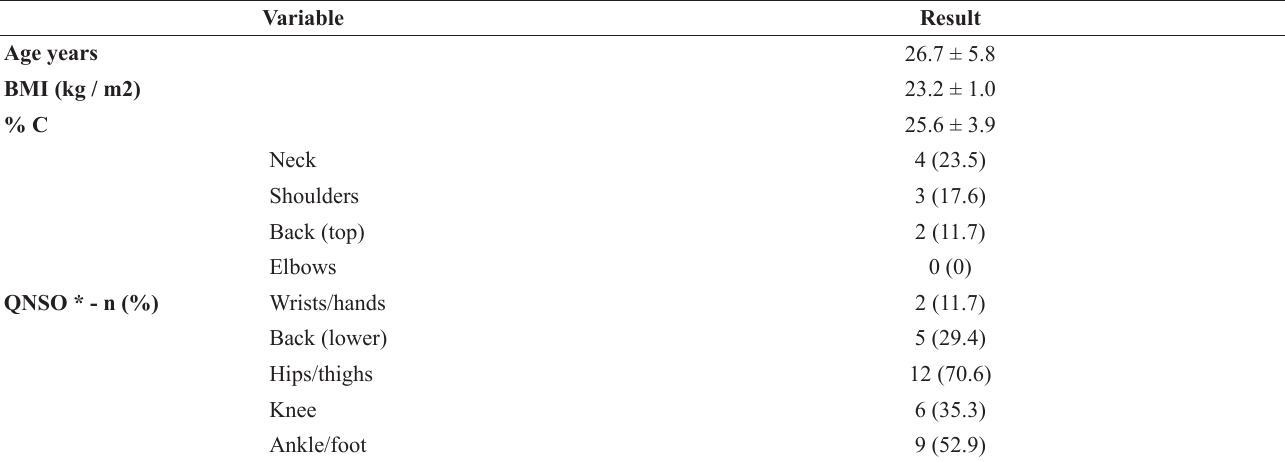
Table 2 - Characteristics of participants included in the study